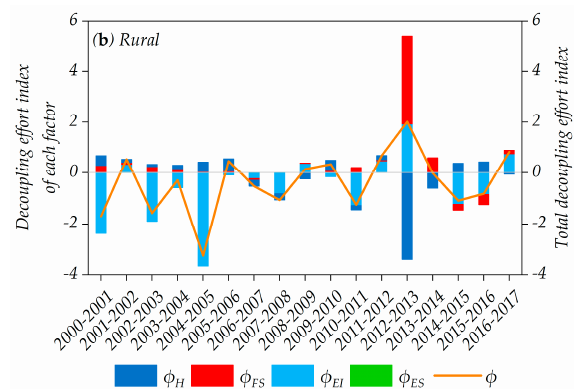
Figure 8. Trends of the decoupling effort index in urban and rural Guangdong. ( a ) Urban. ( b ) Rural.